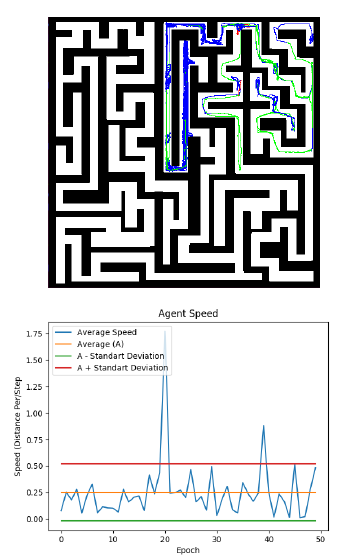
Figure 16. (a) The agent emotional state, and (b) the agent speed with the emotional model’s configurations equal to that shown in row 3 of Table 5.